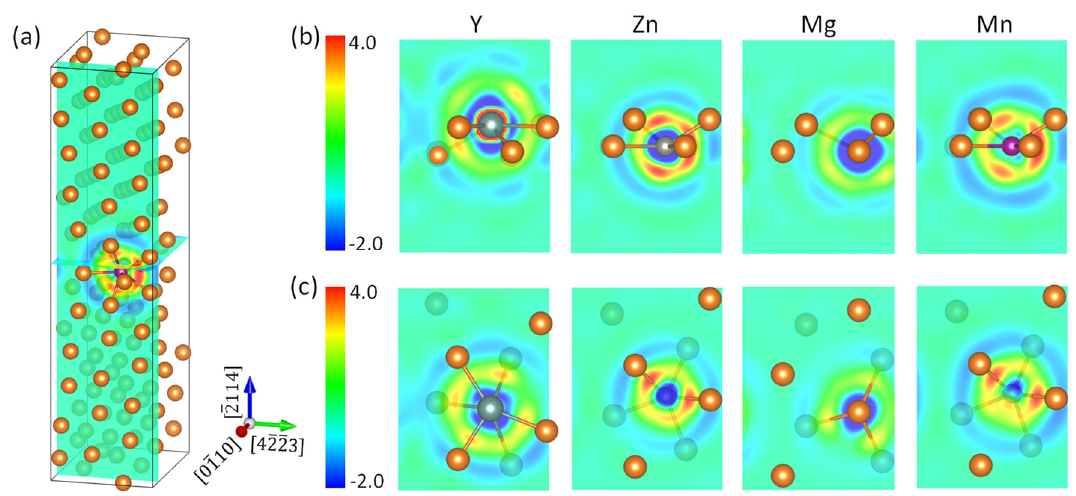
Figure 2. The charge redistribution ( me / Å 3 ) upon formation of the X–Mg bond (X = Y, Zn, Mg, and Mn) at the 2 114) twin boundary in Mg. ( a ) Positions of the (0 1 10) plane containing element X and the ( 2 114) plane in between GB1 and GB2 in the supercell. ( b , c ) The charge redistribution in (0 1 10) and ( 2 114) planes, respectively. Table 1. The variation of charge density redistribution ( e /Å 3 ) upon formation of X–Mg (X = Y, Zn, Mg, and Mn) bonds in the (01 10) and (2 114) planes at the (2 114) twin boundary in Mg (see Figure 2). Y-Mg Zn-Mg Mg-Mg Mn-Mg ∆ ρ − min (0110)